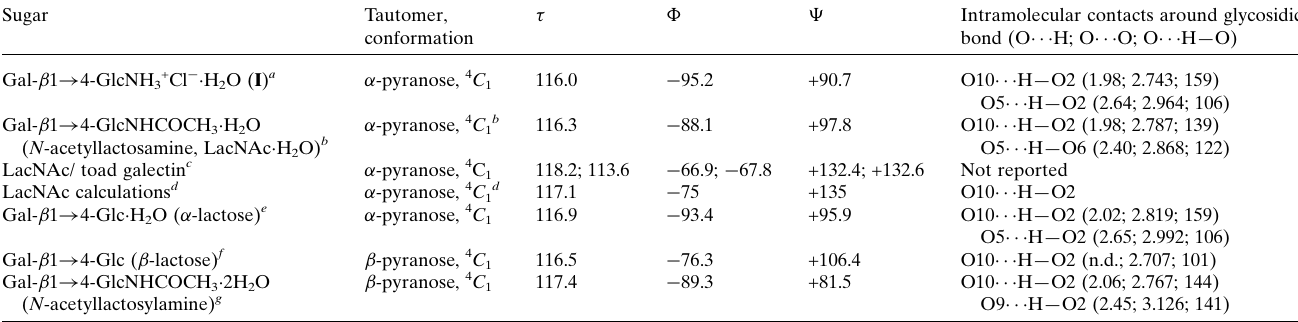
Table 1 Conformational features (A˚ , (cid:5) ) of the glycosidic bond in ( I ) and related disaccharide structures with the Gal- (cid:3) 1 ! 4-Glc link. Sugar Tautomer, conformation